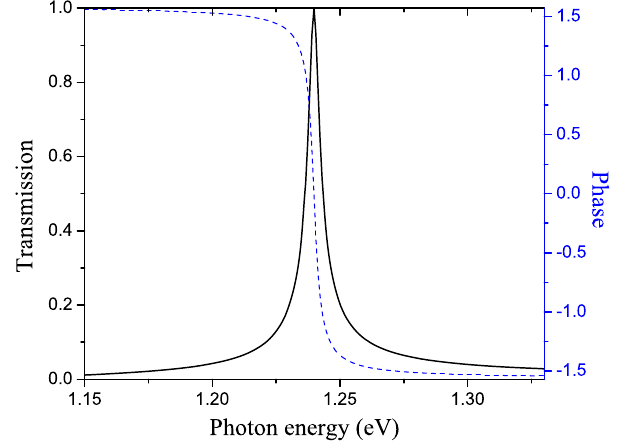
28%.FIG. 11. Transmission and phase for the passband filter used in the cavity to stretch the pulse and suppress the sideband